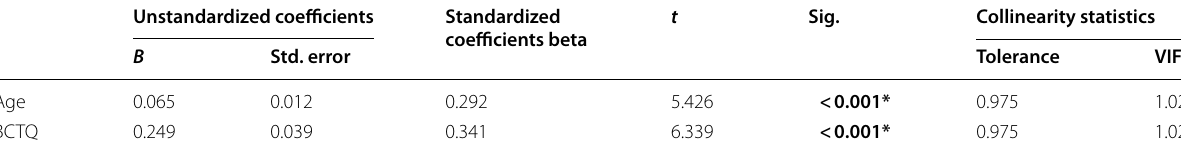
Dependent variable; Median nerve diameter by